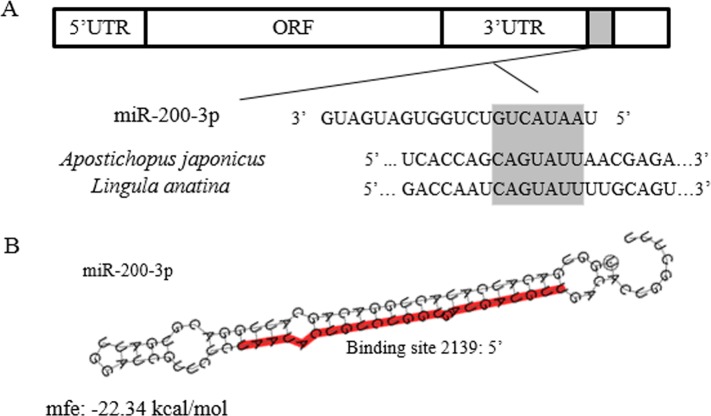
Theoretical binding of miR-200-3p to a conserved region in the 3′ UTR of the AjEHHADH gene.(A) Conservation analysis of the miR-200-3p binding site in the EHHADH gene from sea cucumber A. japonicus and Lingula anatina. The seed region sequence (shaded) shows 100% conservation between these two sequences. (B) Predicted binding structure of miR-200-3p when binding to the 3′ UTR of AjEHHADH, as determined from the TargetScan and miRanda program.